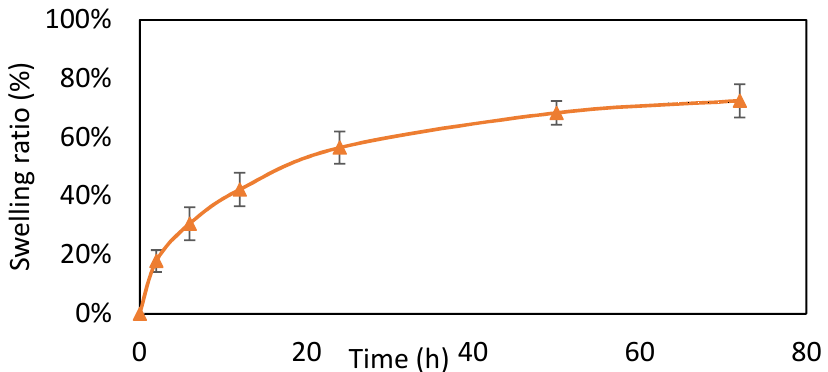
Figure 4. Swelling test ( n = 6). Data are expressed as means ± standard deviation (SD). The composite showed two stages of swelling, including the first stage by HA and the second stage by Gel.